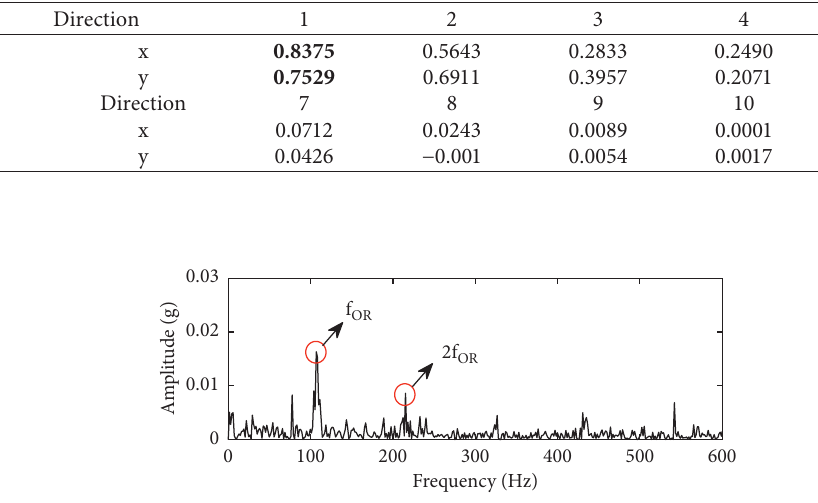
Figure 13: Vector LCD spectra of vector signal under outer race fault condition.